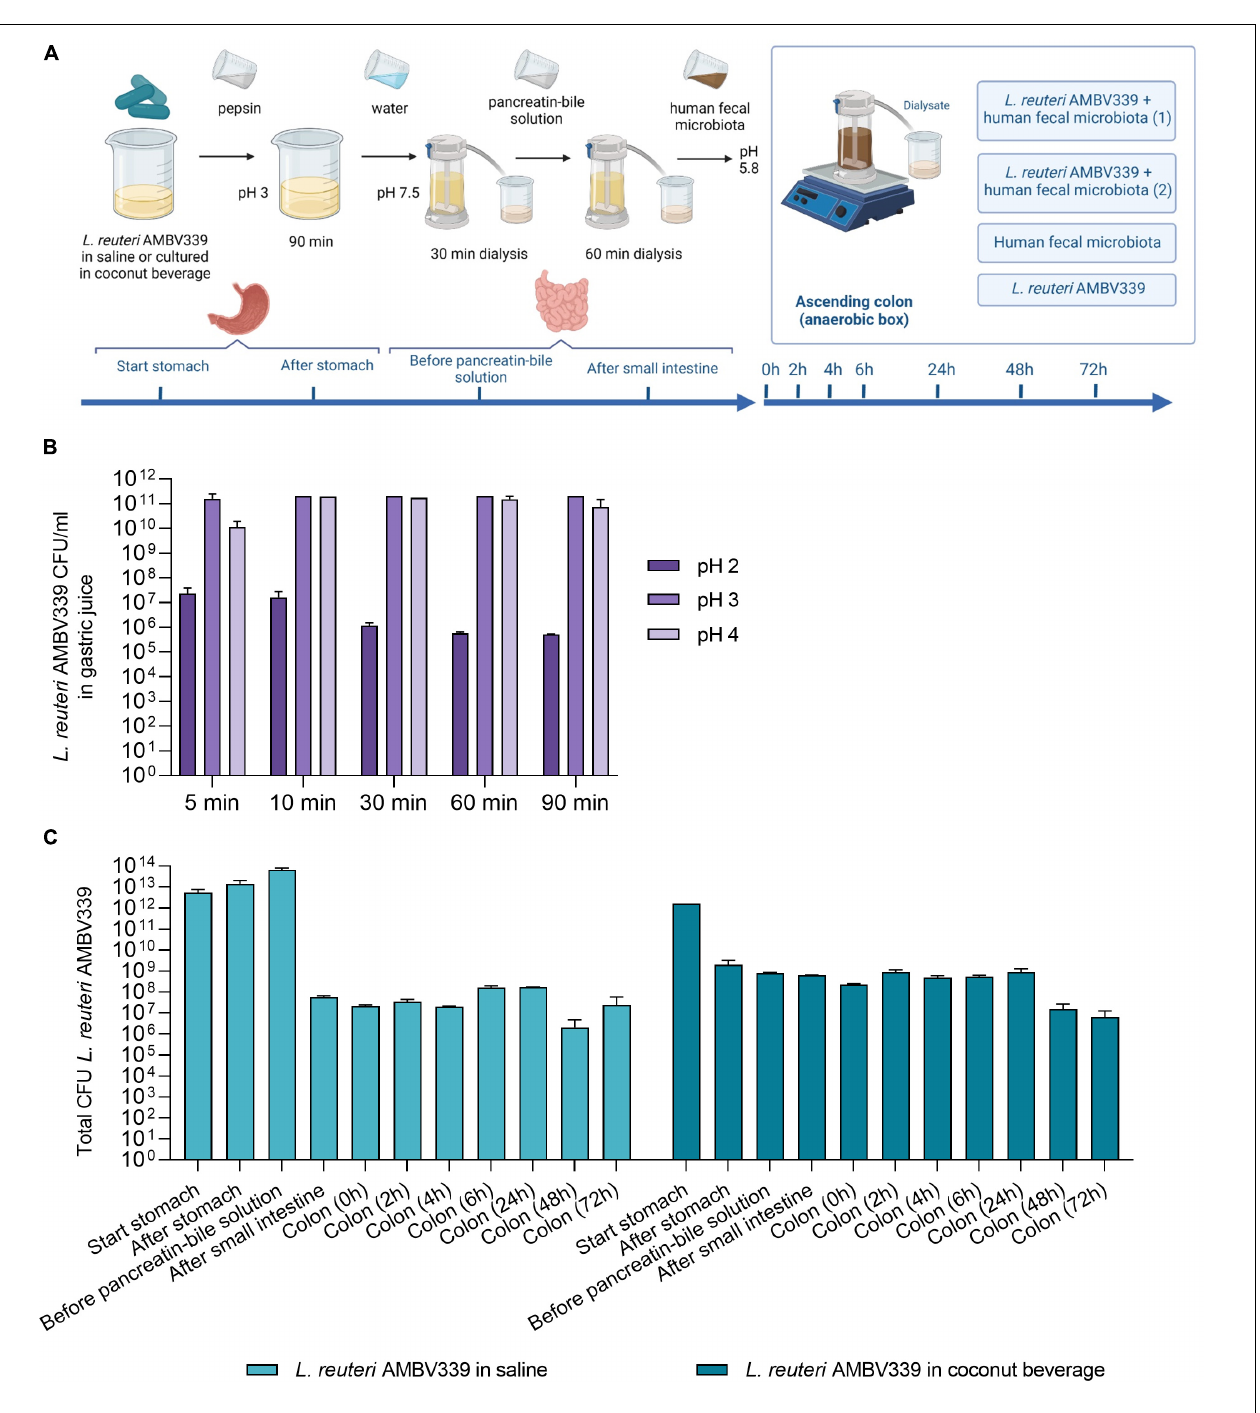
FIGURE 4 | (A) Set-up of L. reuteri AMBV339 testing in the simulated gastrointestinal dialysis model (GIDM-colon), and longitudinal survival of L. reuteri AMBV339 in (B) gastric juice at different pH, or (C) in different parts of the simulated gastrointestinal tract model inoculated with human fecal microbiota. For the simulated gastrointestinal tract L. reuteri AMBV339 in a 0.9% NaCl solution (saline) or L. reuteri AMBV339 in fermented coconut beverage was added. Data is presented as means with standard deviation. Data for gastric juice survival at pH 4 at 30 min was extrapolated from adjacent time points.